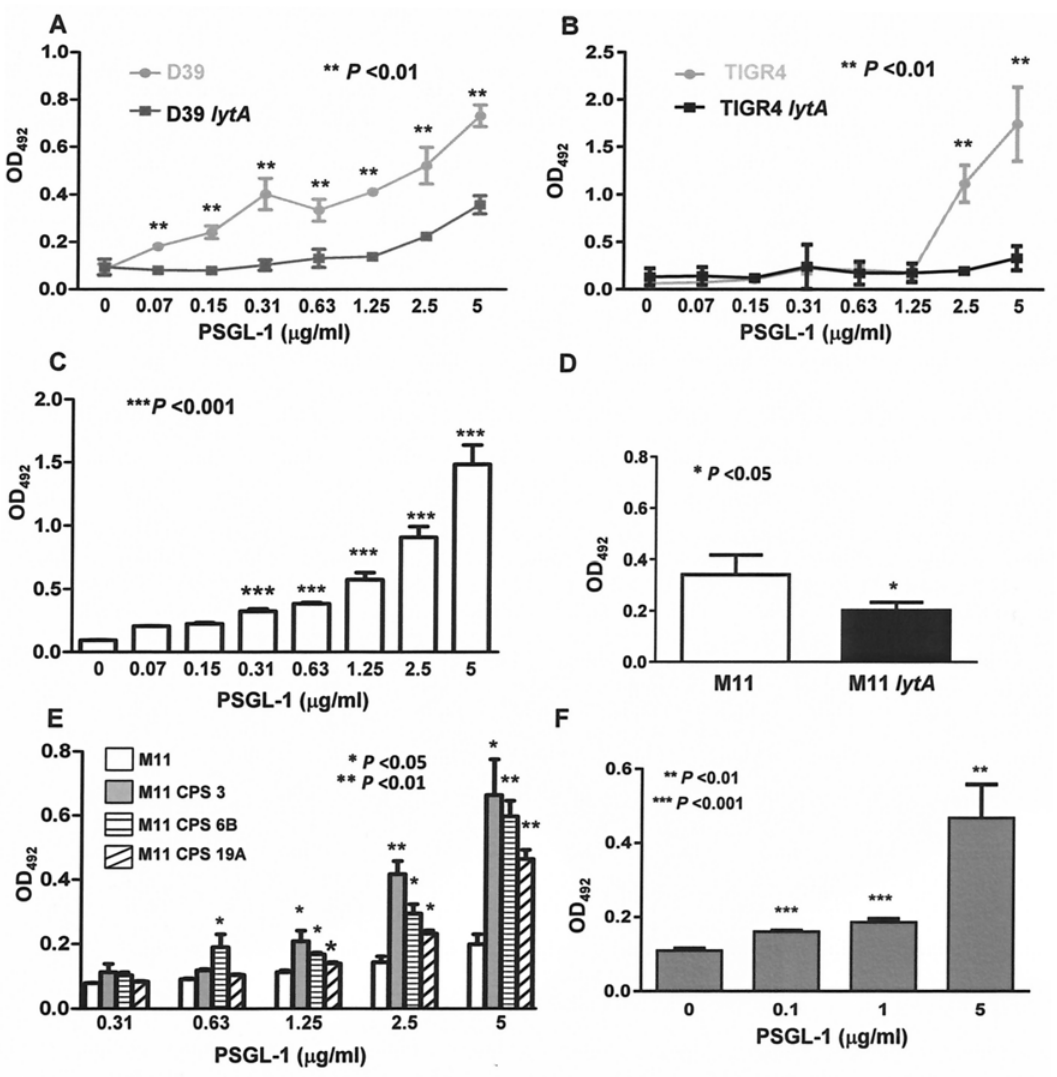
Fig 4. PSGL-1 recognizes the pneumococcal LytA autolysin and the capsular polysaccharide. (A) ELISA showing binding of different concentrations of PSGL-1 to S . pneumoniae D39 (gray circles) and its isogenic lytA mutant (black squares). (B) ELISA showing binding of different concentrations of PSGL- 1 to S . pneumoniae TIGR4 (gray circles) and its isogenic lytA mutant (black squares). (C) ELISA representing binding of 50 μ g of purified LytA protein to different concentrations of PSGL-1. (D) ELISA representing binding of 0.5 μ g/ml of PSGL-1 to M11 strain and an isogenic M11 lytA mutant. (E) ELISA showing binding of different concentrations of PSGL-1 to the unencapsulated M11 strain (open bars) and the corresponding isogenic transformants expressing CPS of serotypes 3 (gray bars), 6B (striped bars) and 19A (hatched bars). (F) ELISA indicating binding of 50 μ g of CPS of serotype 3 (CPS3) to different concentrations of PSGL-1. Error bars represent the SDs and asterisks indicate significant P -values for comparison of results of S . pneumoniae wild- type strains versus the corresponding mutants. For the direct recognition between PSGL-1 and LytA or CPS, asterisks indicate statistical significance of purified LytA protein or CPS3 incubated with PSGL-1 in comparison to the incubation of LytA or CPS3 in the absence of PSGL-1